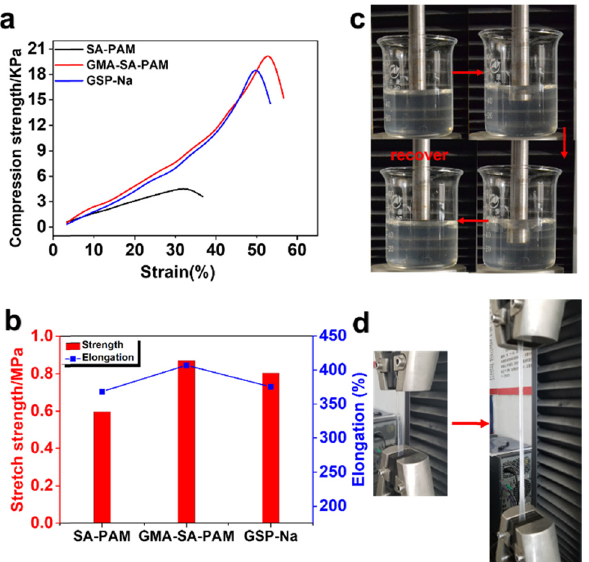
Figure 3: Compression strengths ( a ) and stretch strengths and strain ratios ( b ) of SA - PAM, GMA - SA - PAM, and GSP - Na hydrogels, respectively. Compression process ( c ) and stretch process ( d ) of the GMA - SA - PAM hydrogel, respectively.